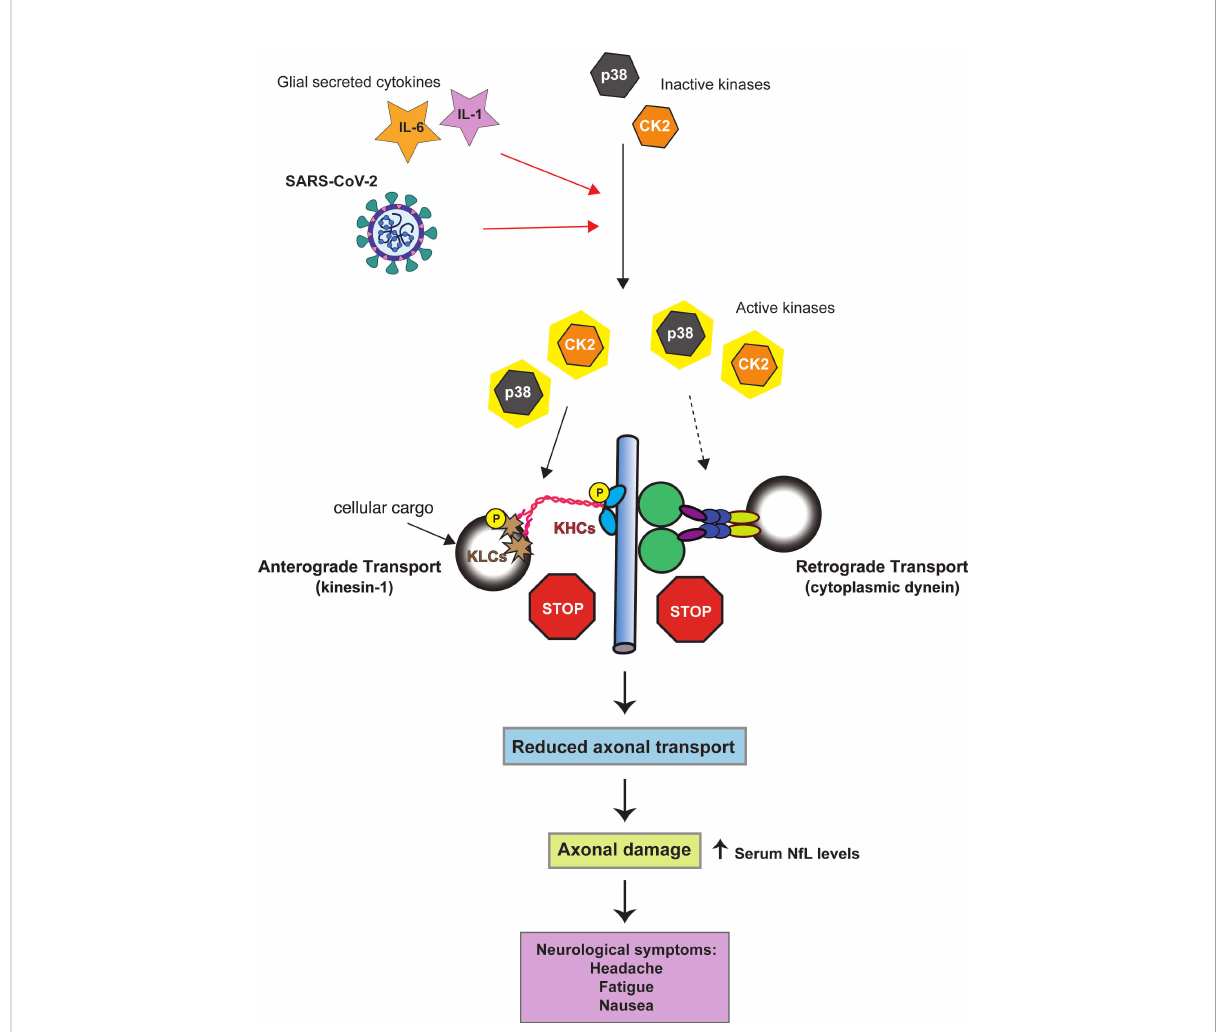
FIGURE 1 Model linking SARS-CoV-2 kinase activation to axonal damage. Both SARS-CoV-2 and the cytokines IL-1 and IL-6 can activate p38-MAPK and CK2 (red arrows). Activation of p38-MAPK and CK2 can impair the axonal transport of the molecular motor proteins cytoplasmic dynein and kinesin-1(conventional kinesin). Solid black arrows indicate phosphorylation of kinesin-1 subunits (KHC = kinesin heave chain, KLC = kinesin light chain). Whether p38-MAPK and CK2 inhibit retrograde axonal transport through dynein phosphorylation has not yet been established (dashed arrow). By altering the activity of kinases involved in the regulation of FAT SARS-CoV-2 may promote FAT abnormalities eventually triggering neuronal dysfunction and